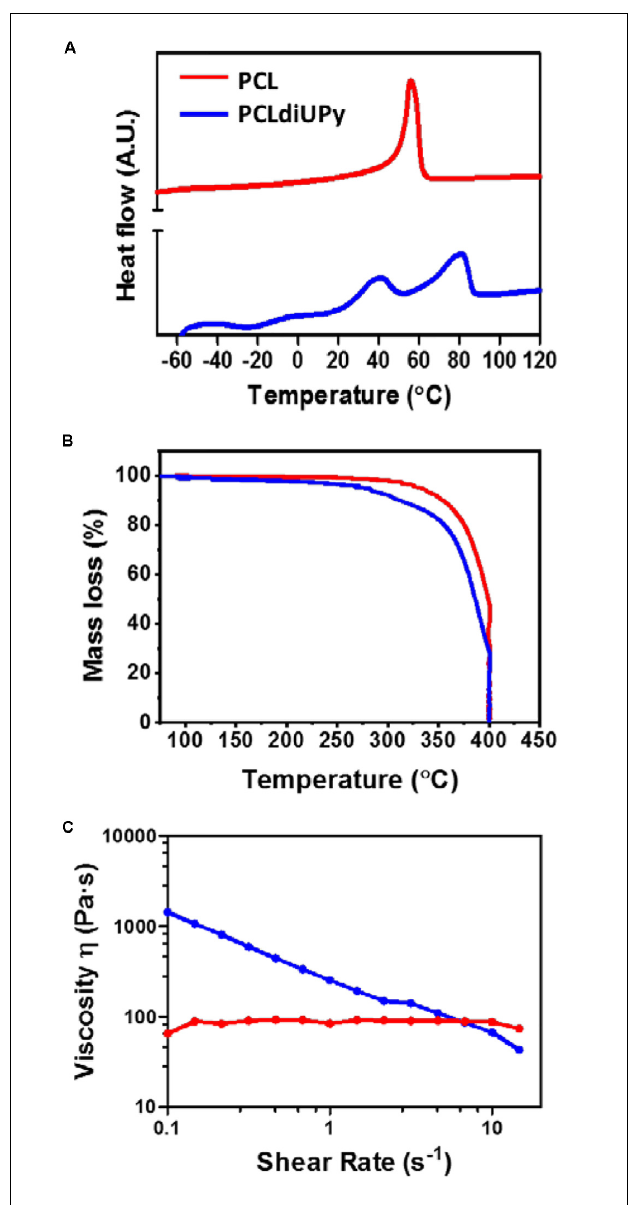
FIGURE 2 | Thermal properties and viscosity analysis. (A) Thermograms of the second heating runs (10 ◦ C/min) are shown. Glass transition temperature ( T g ) and the onset of melting points ( T m ) were determined from thermograms with TA universal analysis. Endothermic processes appear as upward peaks. (B) TGA was measured to determine the decay temperature of all the polymers. (C) Shear-viscosity determined using a rotational rheometer ( n = 3) at 150 ◦ C. PCLdiUPy polymer exhibit shear thinning property, displayed by a decrease in viscosity upon an increase in shear rate.